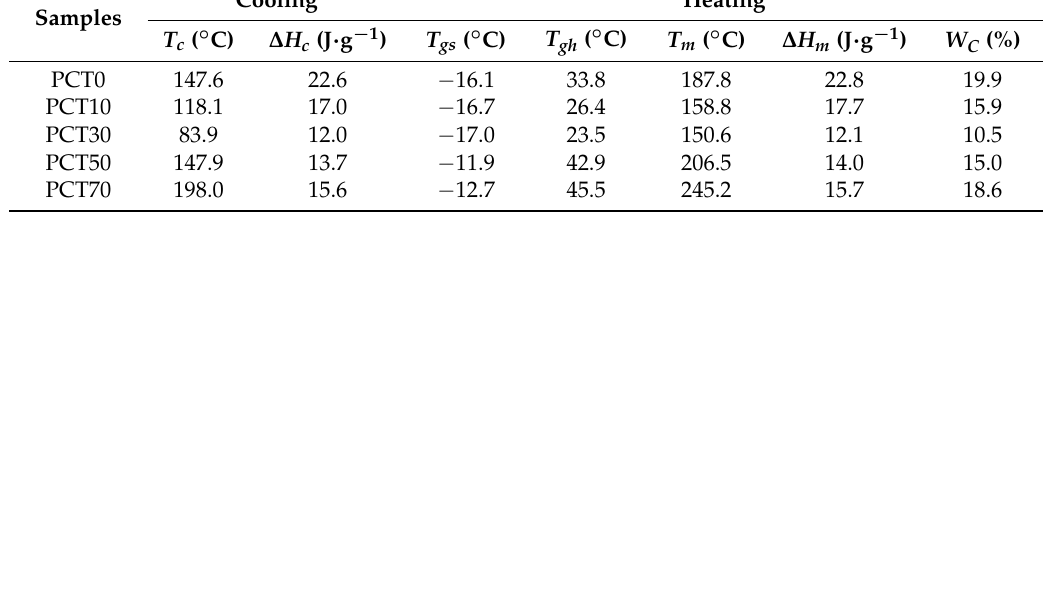
Table 5. Thermal properties of the (PBT-co-PCT)-b-PTMG copolymers obtained from DSC.